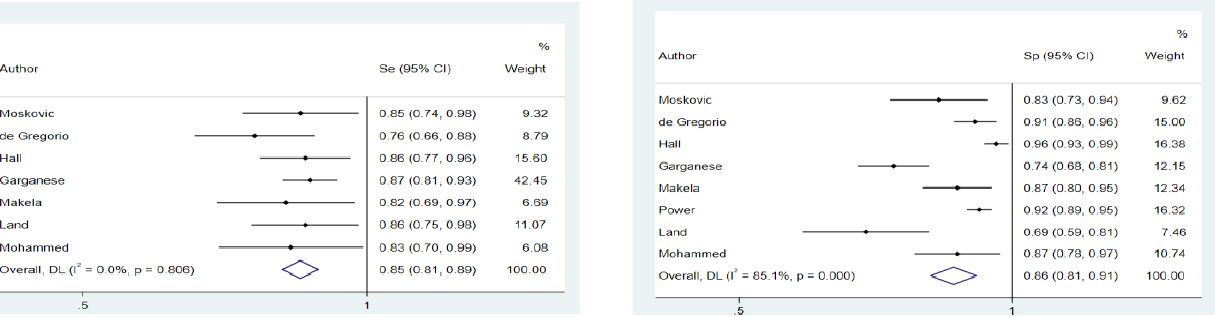
Figure 2. Forest plot for sensitivity and specificity.